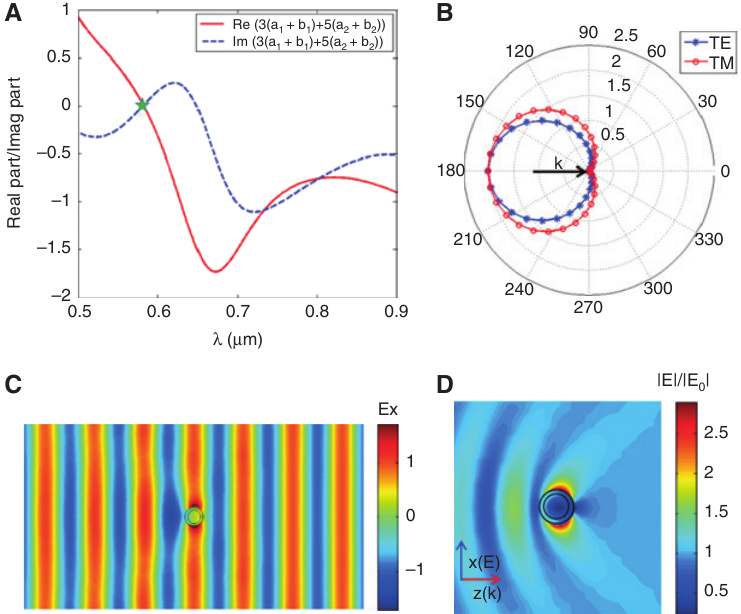
+ b + b ) + 5( a ) = 0 for the used core-shell spherical nanoparticle as a function of 1 1 2 2